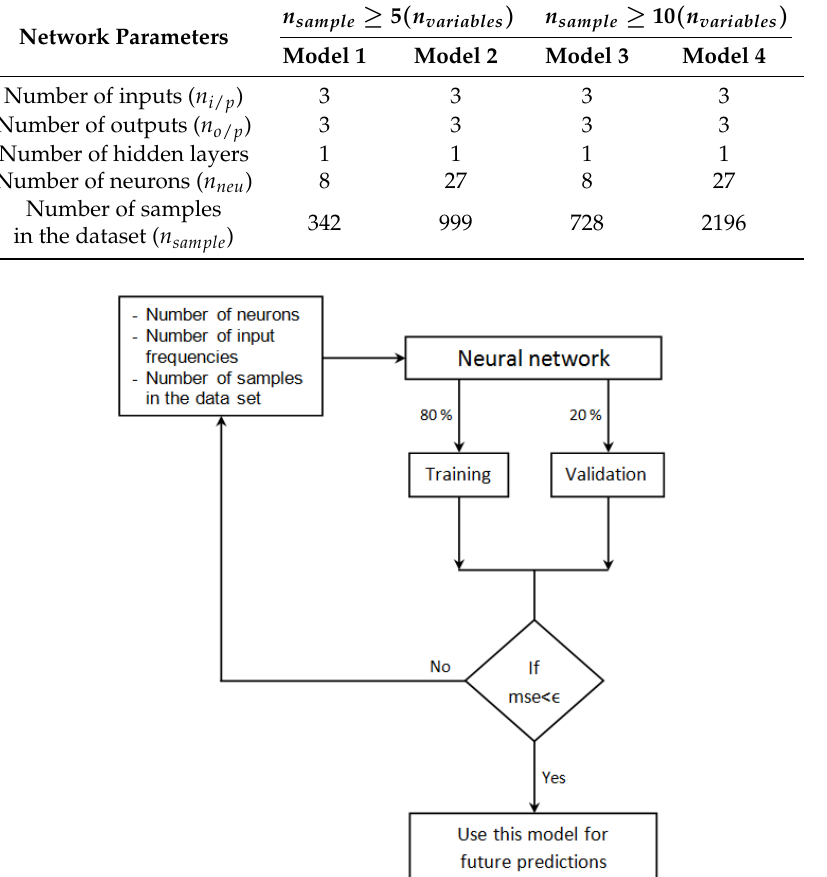
Figure 8. Flowchart for the neural network